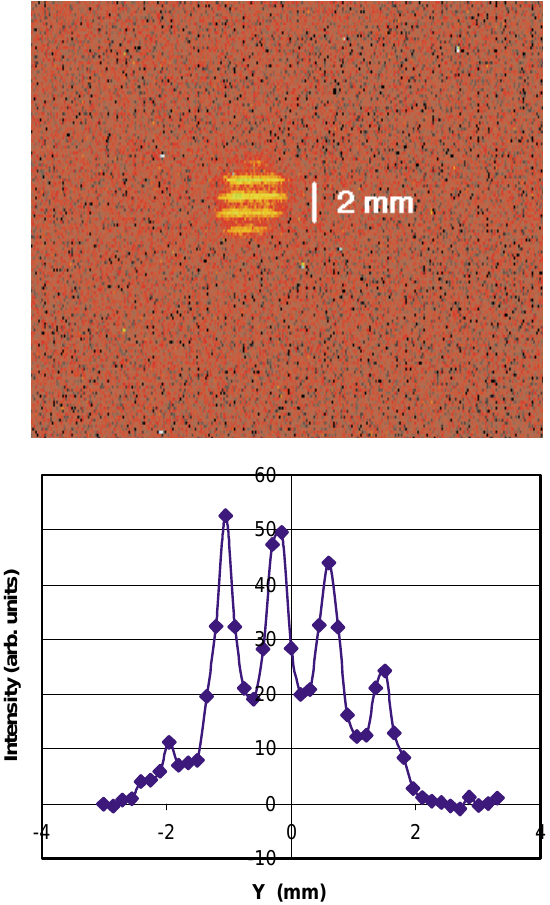
FIG. 10. (Color) Image of individual beamlets produced by the slits after a 13 cm drift length (top), and the relative intensity of the beamlets averaged over x as a function of y (bottom). The geometric emittance of this beam is 0.9 p mm mrad with an estimated bunch charge of 12 pC. The relativistic factor bg is about